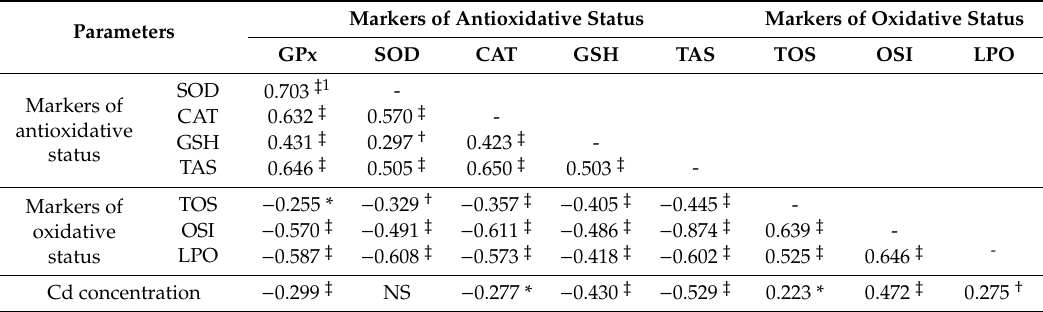
Table 4. Mutual relationships between the investigated markers of the oxidative / antioxidative status of the submandibular gland and cadmium (Cd) concentration in this salivary gland of female